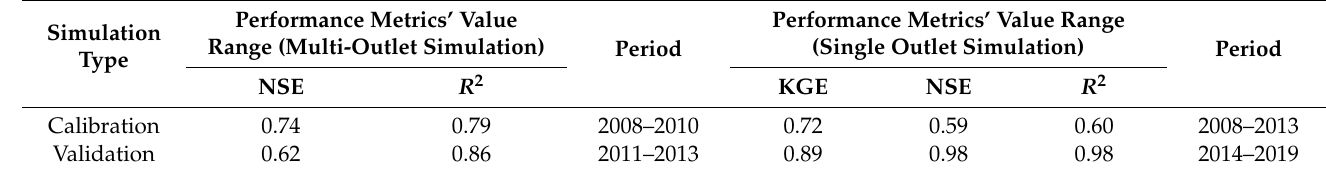
Table 5. Evaluation results of single-outlet and multi-outlet simulation effect.